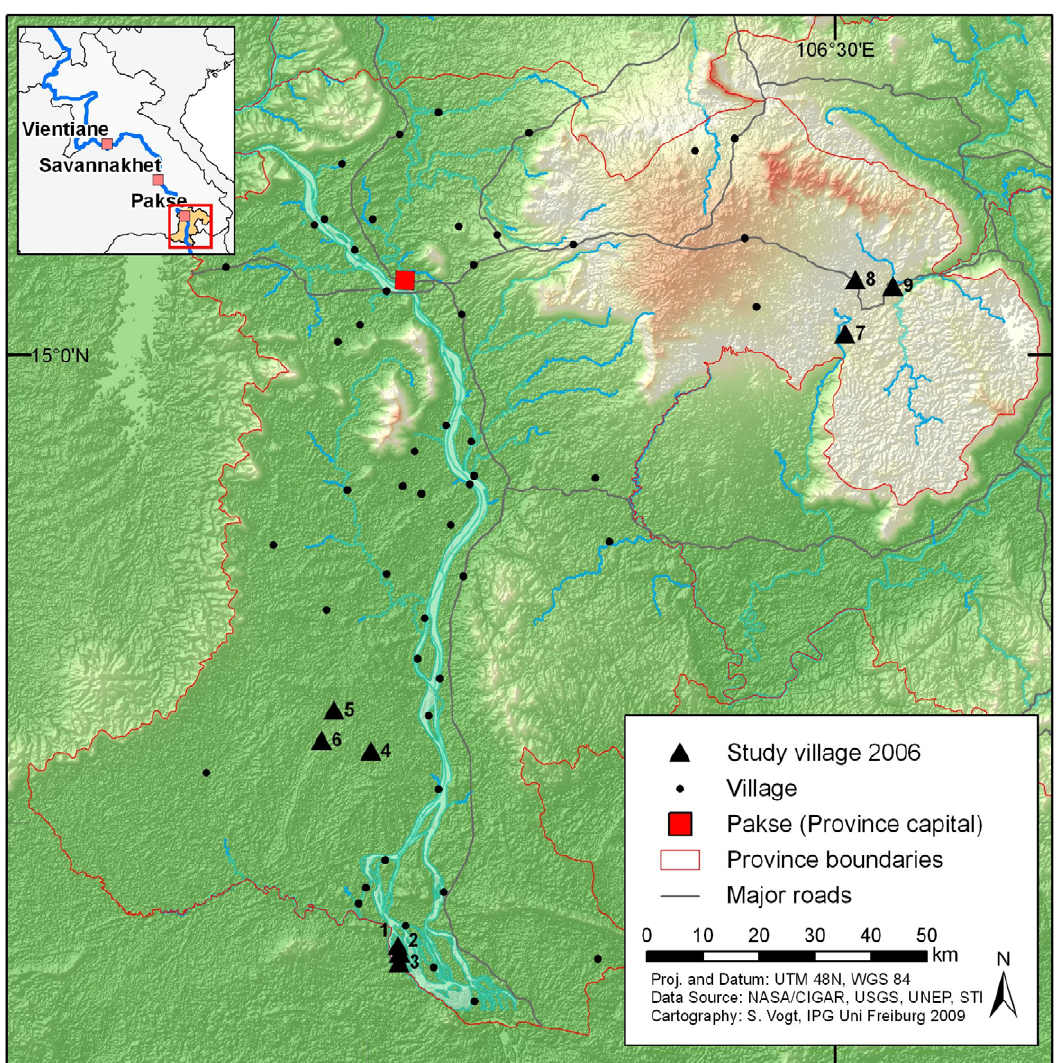
Figure 1. Map of Champasack province in southern Lao PDR with location of study villages sampled in early 2006.